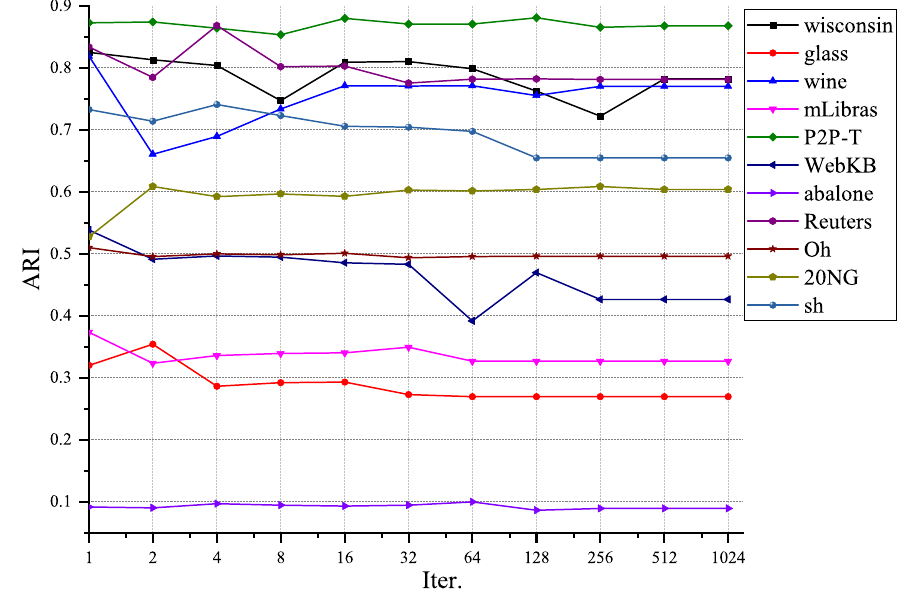
Figure 5. ARIs correspond to different iteration numbers.